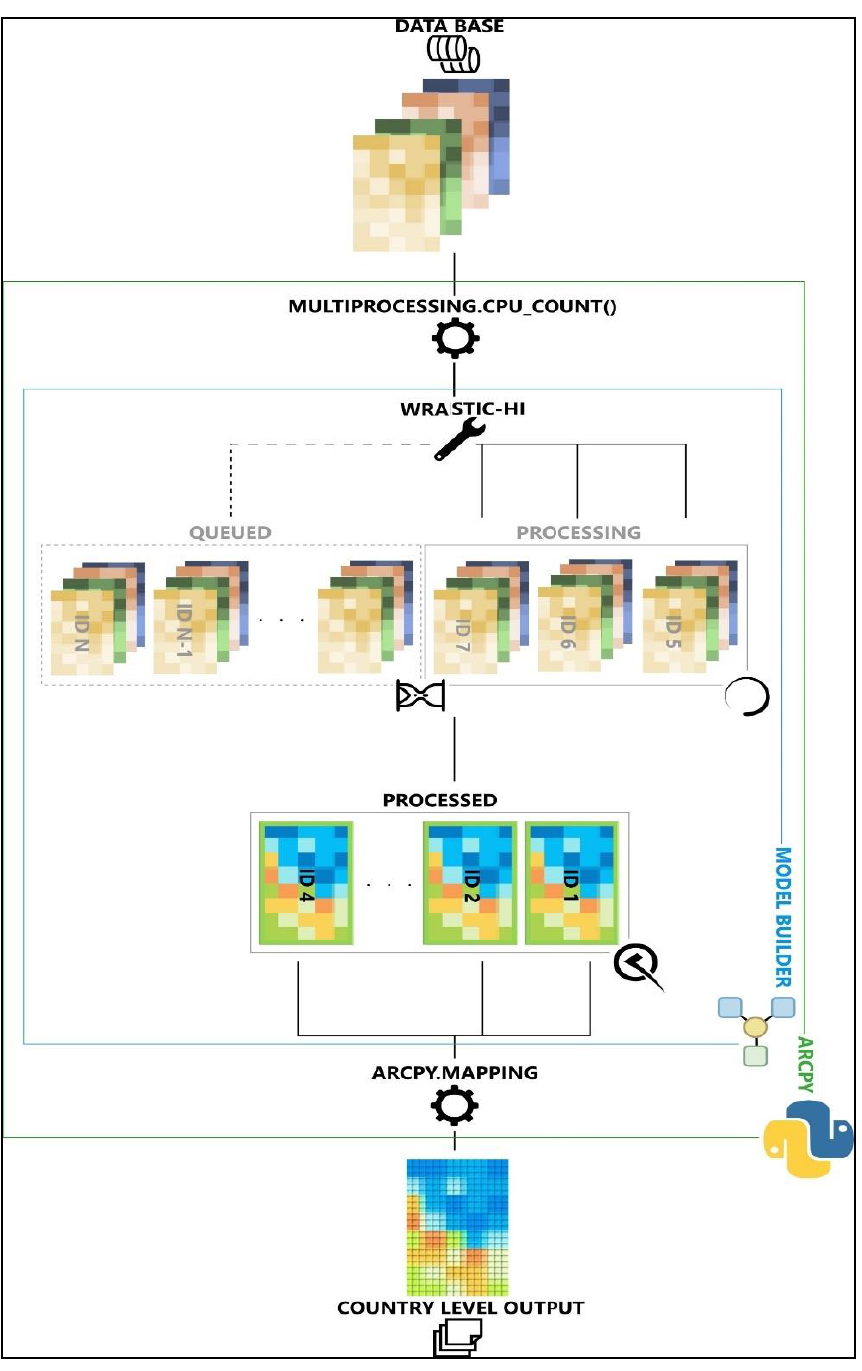
Figure 2. Workflow representation.